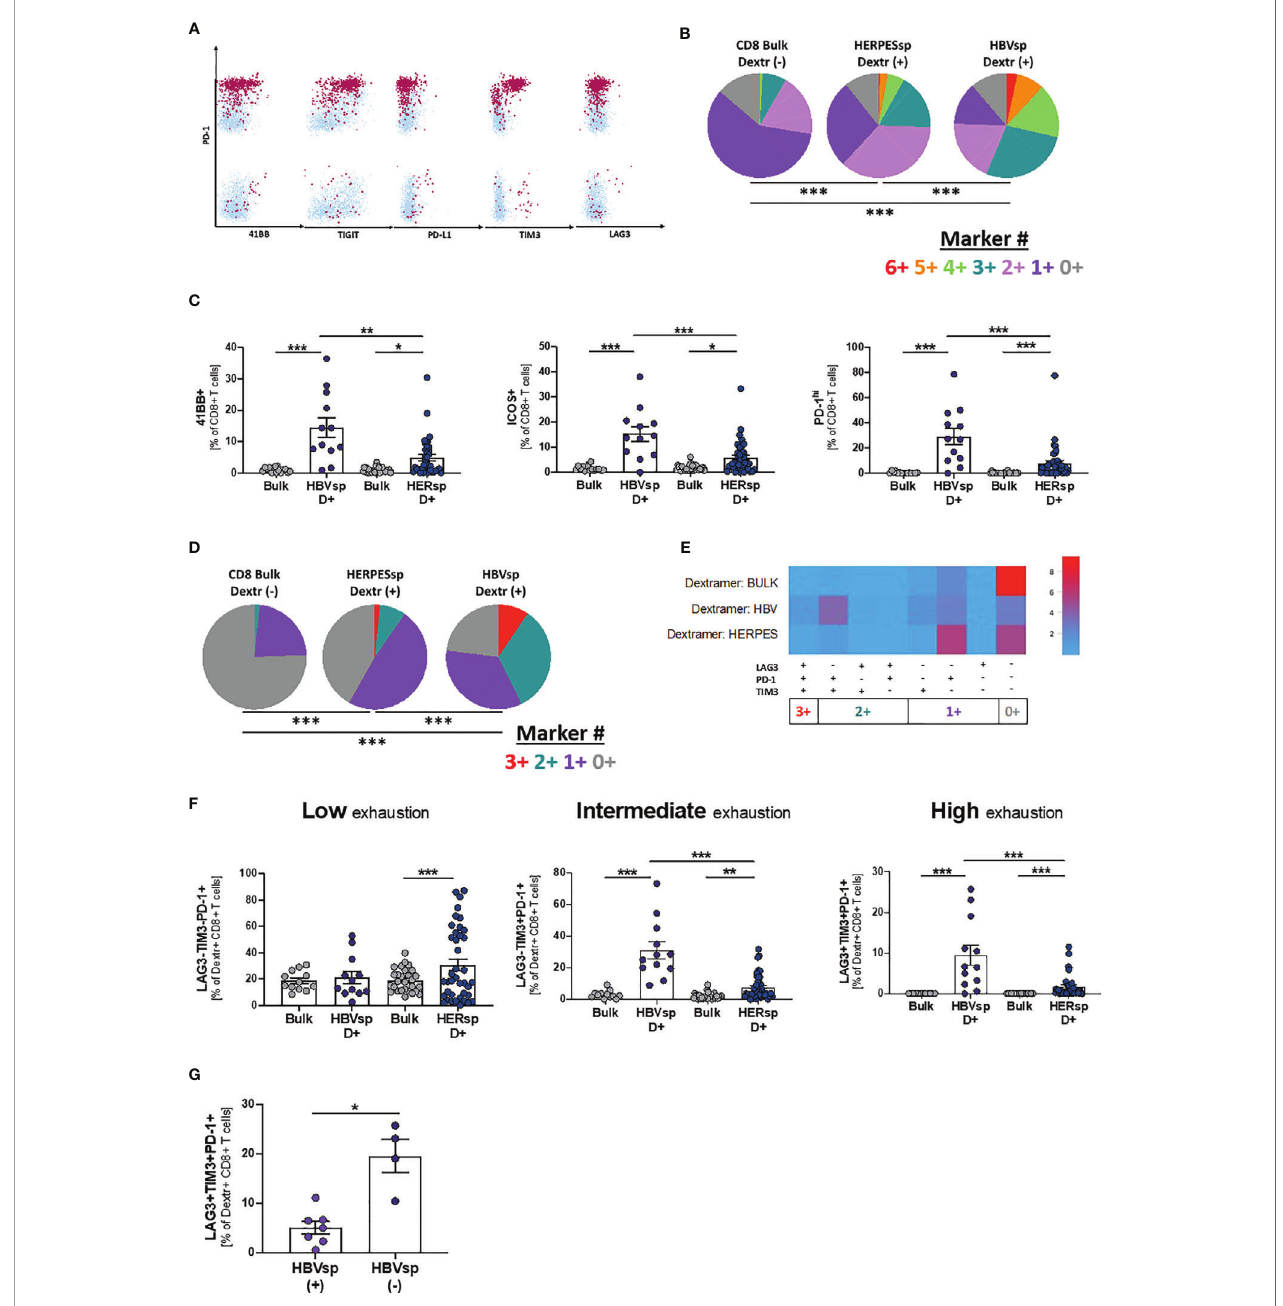
FIGURE 3 | HBV-speci fi c CD8 T cells express high frequency of exhaustion markers. (A) Representative fl ow plots showing expression levels, on HBV-speci fi c CD8 T cells, of inhibitory (iR) and activating (aR) receptors included in the SPICE analysis. Dextramer-positive HBV-speci fi c CD8 T cells (maroon) are overlaid on bulk CD8 T cells (light blue). (B) SPICE analysis showing the distribution of inhibitory receptors ( 6 + markers for 41BB+PD-1+TIGIT+PD-L1+TIM3+LAG3+) in bulk CD8 T cells (left pie), HERPES-speci fi c CD8 T cells (CMV and/or EBV, middle pie ) and HBV-speci fi c CD8 T cells (core and/or pool, right pie). ***p < 0.0001; Permutation test. (C) Frequency of 41BB ( left panel ), ICOS ( middle panel ) and PD-1hi (right panel) expression in bulk, HBV-speci fi c (core and/or pool) and HERPES-speci fi c (CMV and/ or EBV) CD8 T cells. *p < 0.05; **p < 0.001; ***p < 0.0001; Wilcoxon signed rank test (bulk vs. Ag-speci fi c) and Mann-Whitney U (HBV-speci fi c vs. HERPES- speci fi c). Frequency of bulk, HBV-speci fi c (core and/or pool) and HERPES-speci fi c (CMV and/or EBV) CD8 T cells with phenotype consistent with low exhaustion (LAG3-TIM3-PD-1+, 1 + markers), intermediate exhaustion (LAG3-TIM3+PD-1+, 2+ markers ) or high exhaustion (LAG3+TIM3+PD-1+, 3 + markers) shown as (D) SPICE analysis; ***p < 0.0001; Permutation test, (E) SPICE CoolPlot and (F) pooled data; **p < 0.001; ***p < 0.0001; Wilcoxon signed rank test (bulk vs. Ag- speci fi c) andMann-Whitney U (HBV-speci fi c vs. HERPES-speci fi c). (G) Frequency of HBV-speci fi c CD8T cellswith a high exhaustion phenotype(LAG3+TIM3+PD-1+) amongpatients with [HBVsp(+)] orwithout [HBVsp(-)] ex vivo HBV-speci fi c reactivity (core and/or pool). * p < 0.05; Mann Whitney U